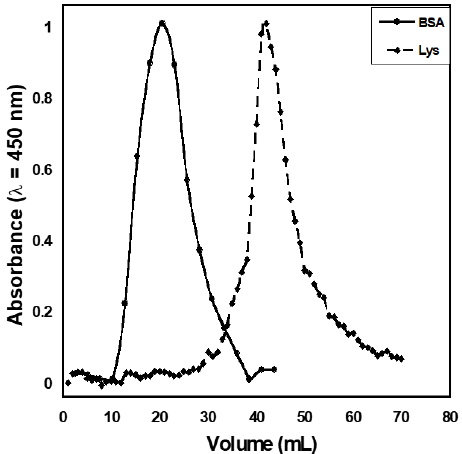
Figure 3. Low-pressure size-exclusion chromatograms of the globular proteins bovine serum albumin (BSA, molecular mass 66.5 kDa) and lysozyme from egg (Lys, molecular mass = 14.4 kDa). The absorbances of each chromatogram have been divided by the value of the peak recorded at the maximum absorptivity in the UV-Vis